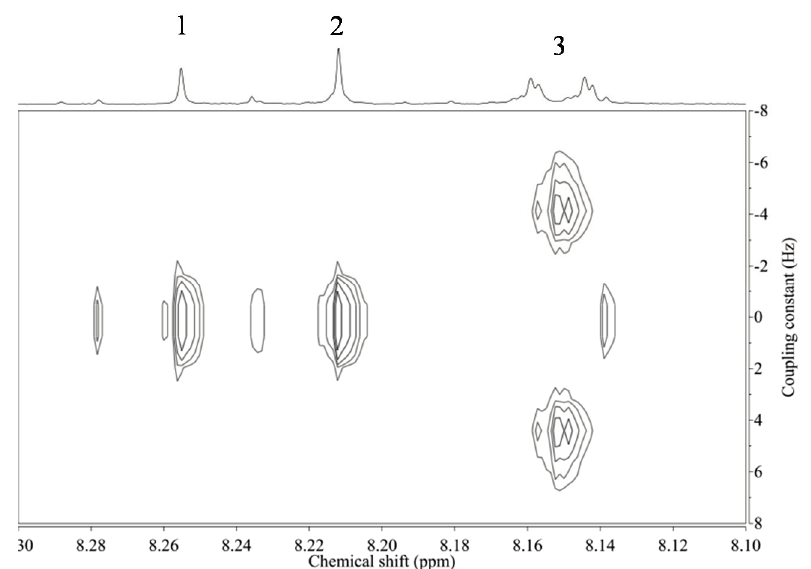
Figure 4. 1 H- 1 H-J-resolved spectrum of Astragalus membranaceus roots collected in in the Shanxi province in China (No. of voucher specimen: 20131206-5) in CD 3 OD. 1: H-2 of formononetin-7- O -glucoside, 2: H-2 of calycosin-7- O -glucoside, 3: H-5 of formononetin- 7- O -glucoside and calycosin-7- O